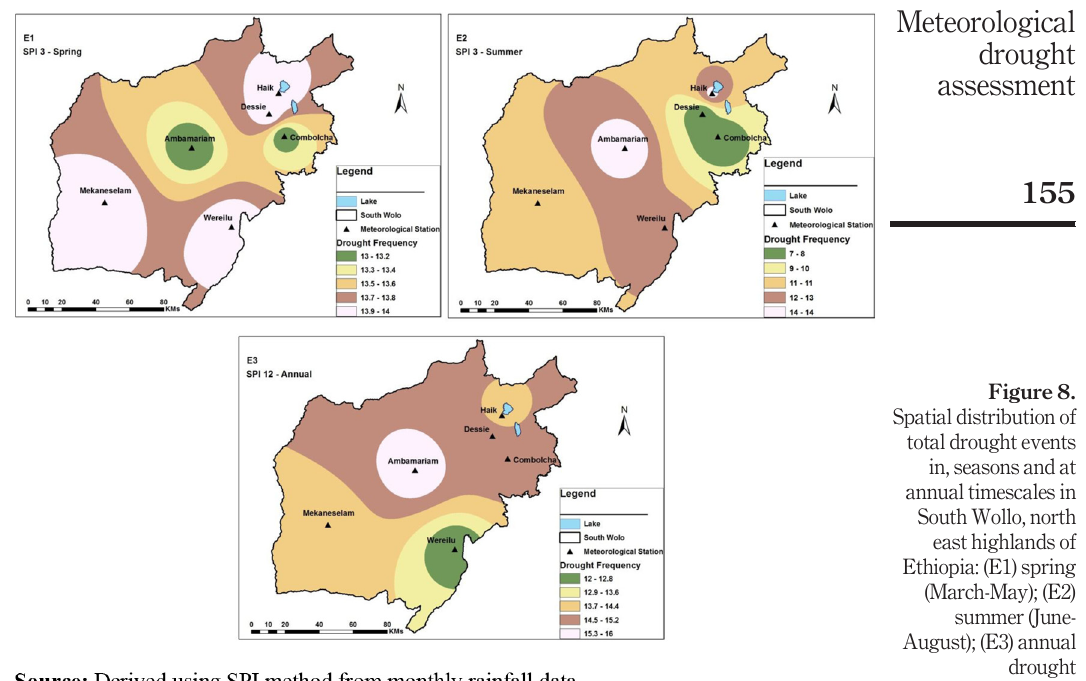
Figure 8. Spatial distribution